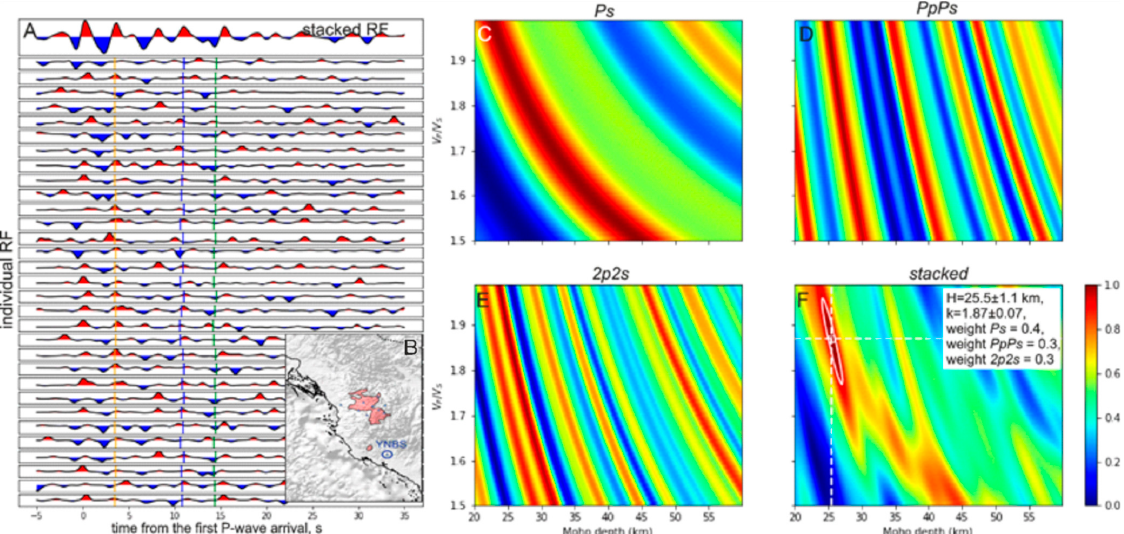
Figure 8. Results of the H-k stacking for the station RHT01 located in the northern part of Harrat– Rahat. ( A ): Individual receiver functions (Q-component). The upper trace is the average of all traces. Red, blue, and green hatches mark the theoretical arrivals of the Ps , PpPs and 2p2s phases, respec- tively. ( B ). The location of the station on the map. ( C – E ): Grid search results for three individual phases Ps , PpPs and 2p2s . ( F ): Result of stacking of the results for all phases. The white dashed lines mark the best solution. The parameters of stacking and results for H and k determination are shown on the panel F.